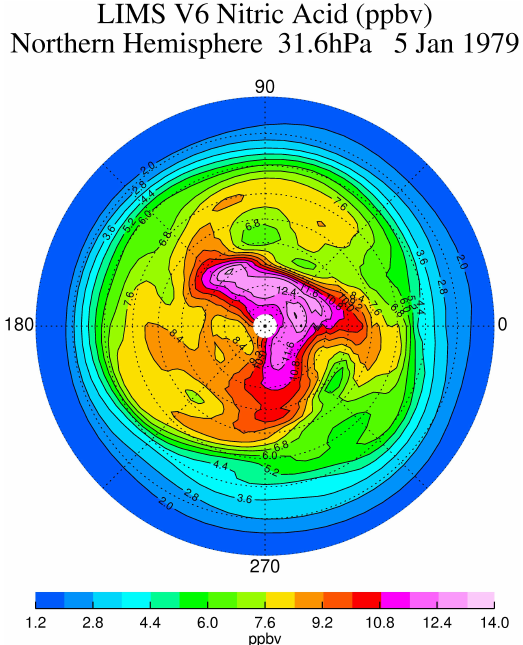
Fig. 8. Ascending plus descending V6 HNO 3 inppbv for 5 Jan- uary 1979. Bluish regions are low values and orange-to-pink re- gions are high values; contour interval is